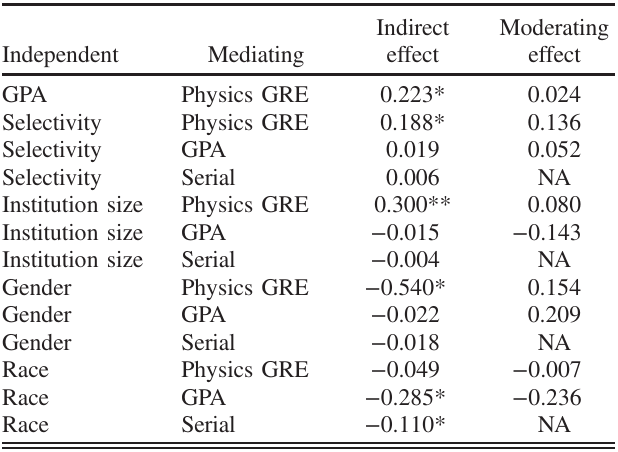
TABLE IV. Summary of the mediating and moderation results. * signifies partial mediation is present, ** signifies full mediation is present, † signifies moderation is present. However no moderation effects were